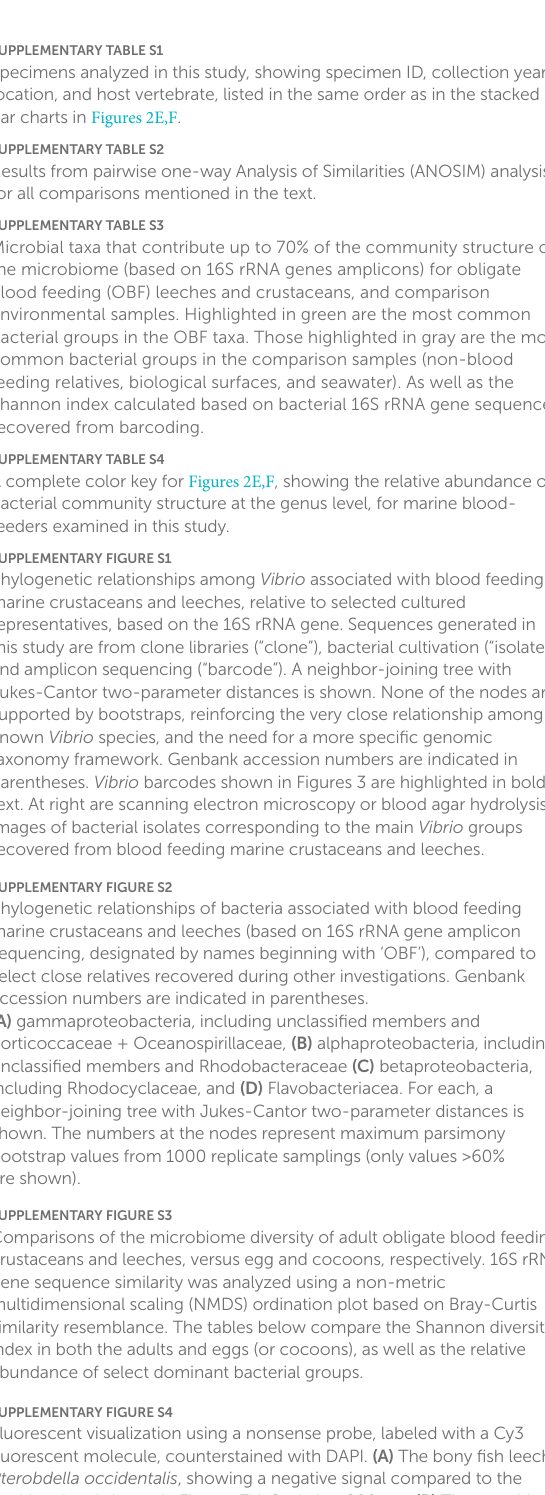
SUPPLEMENTARY FIGURE S3 Comparisons of the microbiome diversity of adult obligate blood feeding crustaceans and leeches, versus egg and cocoons, respectively. 16S rRNA gene sequence similarity was analyzed using a non-metric multidimensional scaling (NMDS) ordination plot based on Bray-Curtis similarity resemblance. The tables below compare the Shannon diversity index in both the adults and eggs (or cocoons), as well as the relative abundance of select dominant bacterial groups. SUPPLEMENTARY FIGURE S4 Fluorescent visualization using a nonsense probe, labeled with a Cy3 fluorescent molecule, counterstained with DAPI. (A) The bony fish leech Pterobdella occidentalis , showing a negative signal compared to the positive signal shown in Figures 7H. Scale bar 200 μ m. (B) The parasitic isopod Elthusa vulgaris , showing a negative signal compared to the positive signal shown in Figures 7F. Scale bar 100 μ m. (C) Lernanthropus latis, showing a negative signal, compared to panel E. Scale bar 20 μ m. (D) The elasmobranch leech Branchellion lobata , showing a negative signal, compared to panel F. Scale bar 20 μ m. (E) Lernanthropus latis, showing the result from the Vibrio -specific fluorescent probe revealing rod-shaped bacterial cells, shown in orange via Cy3. Scale bar 20 μ m. (F) Branchellion lobata, showing the result from the Vibrio -specific fluorescent probe revealing rod-shaped bacterial cells, shown in